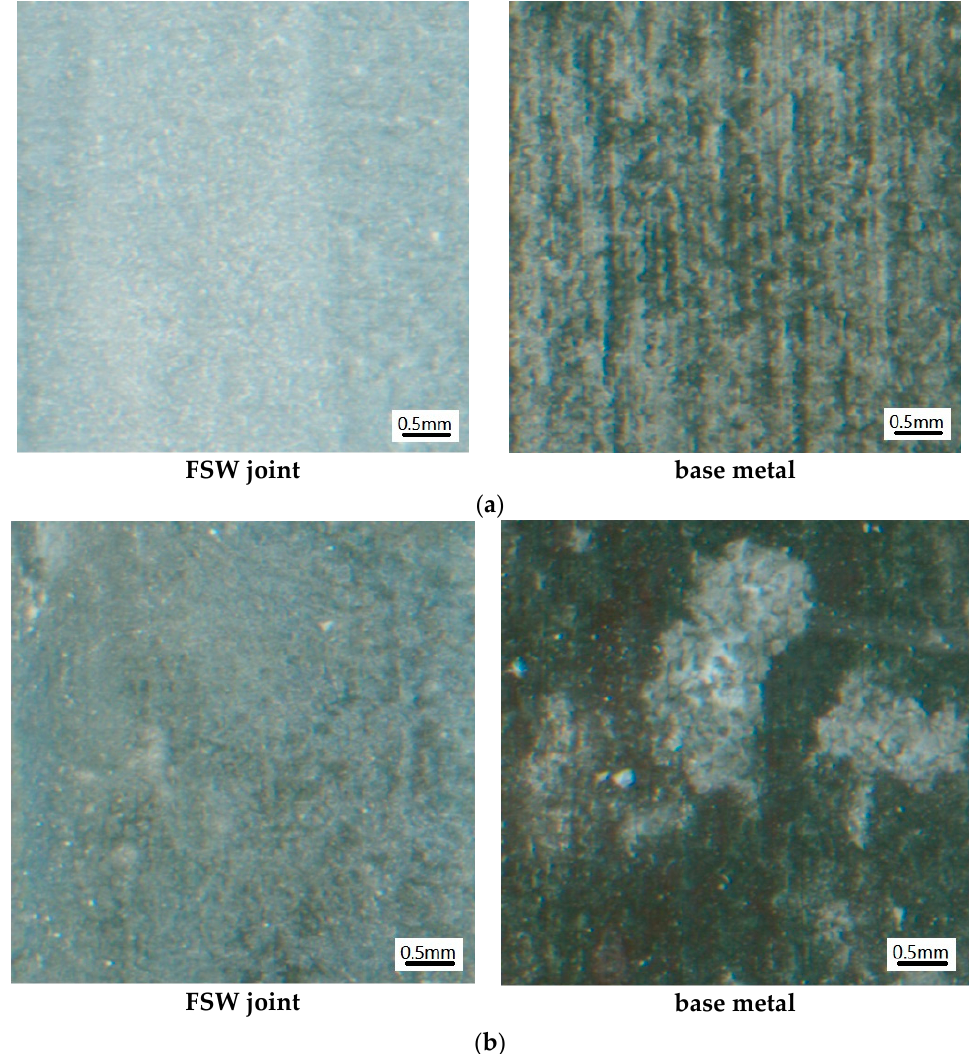
Figure 6. A comparison of the macroscopic morphology of damage resulting as a consequence of exposure to the environment (EXCO solution): ( a ) duration of exposure = 8 h at an applied stress ( σ ) of 79 MPa; ( b ) duration of exposure = 24 h at an applied stress ( σ ) of 79 MPa.